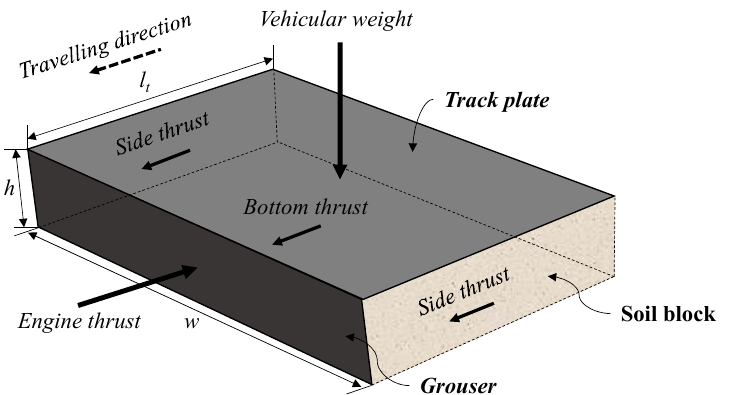
Figure 3. Schematic diagram of the vehicular load of an individual grouser and the block-shaped failure plane.